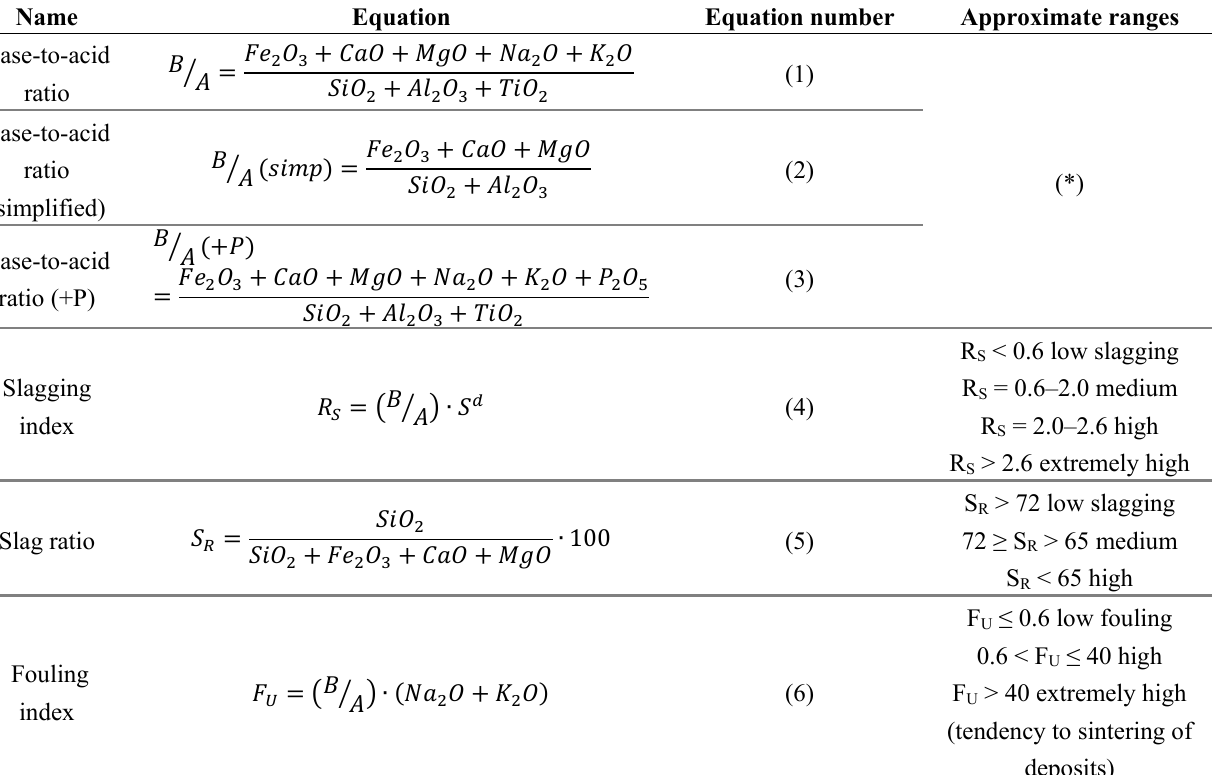
Table 3. Theoretical deposition rates. Ratios, equations and approximate